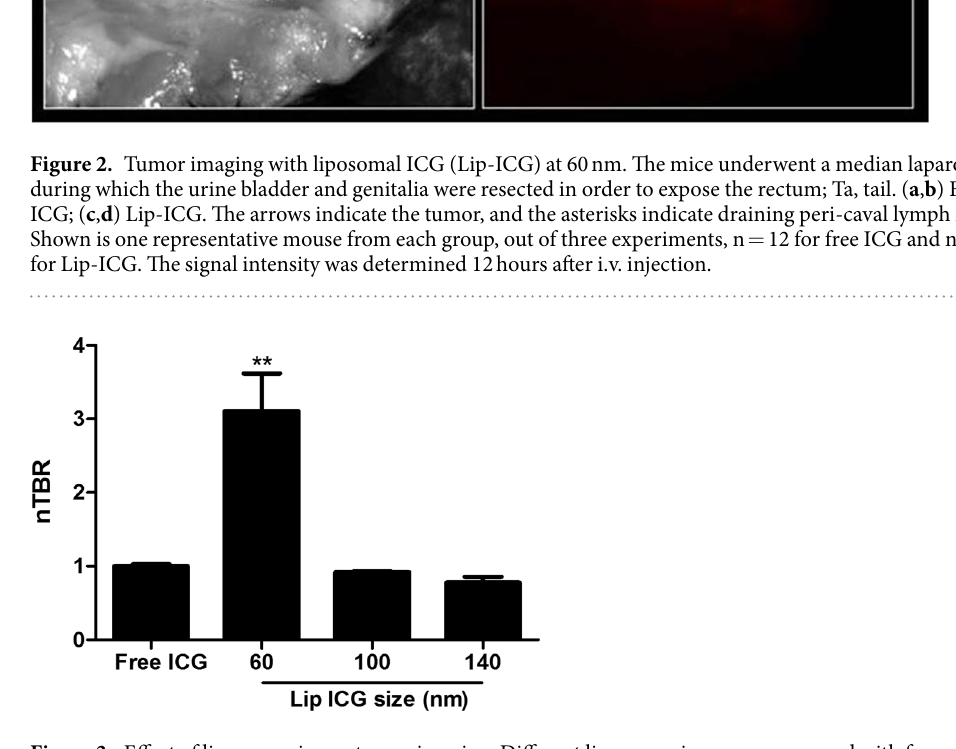
Figure 3. Effect of liposome size on tumor imaging. Different liposome sizes were compared with free ICG, 12 hours after i.v. injection. The results are the summary of two experiments, n = 4 for each size. nTBR = normalized TBR (relative to TBR of free ICG). ** p =